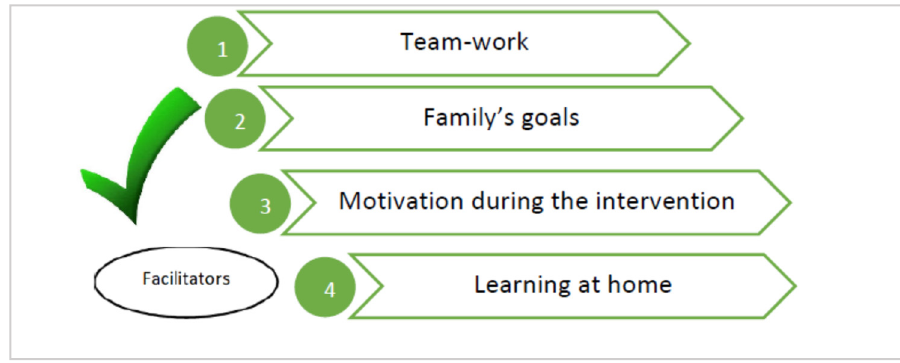
Figure 5. Facilitators present in the UCP early intervention from the families’ perspectives.